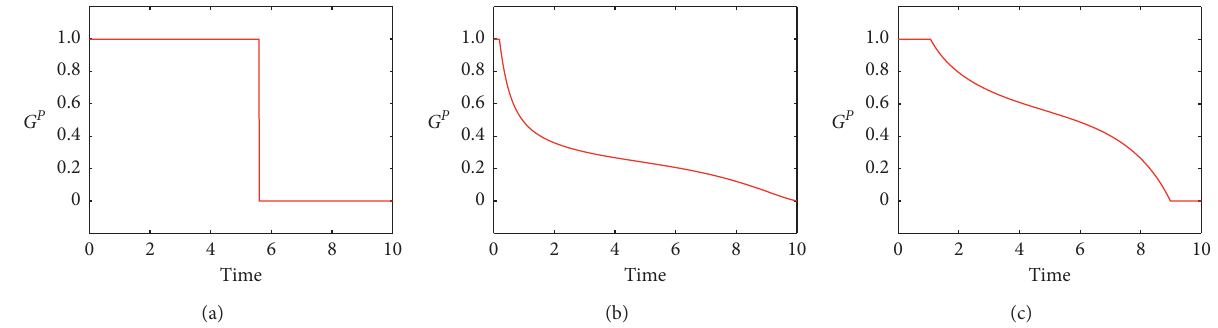
Figure 8: The promising rumor-containing scheme G p for three pairs of ( θ ( x ) � θ 2 θ 1